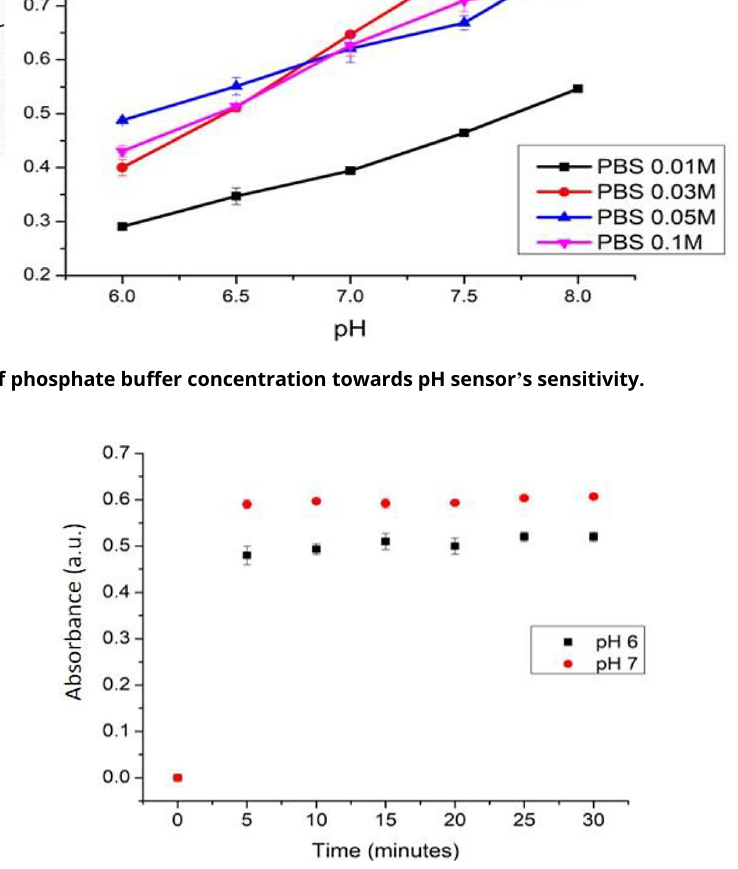
Figure 12. The response time profile of pH sensor.